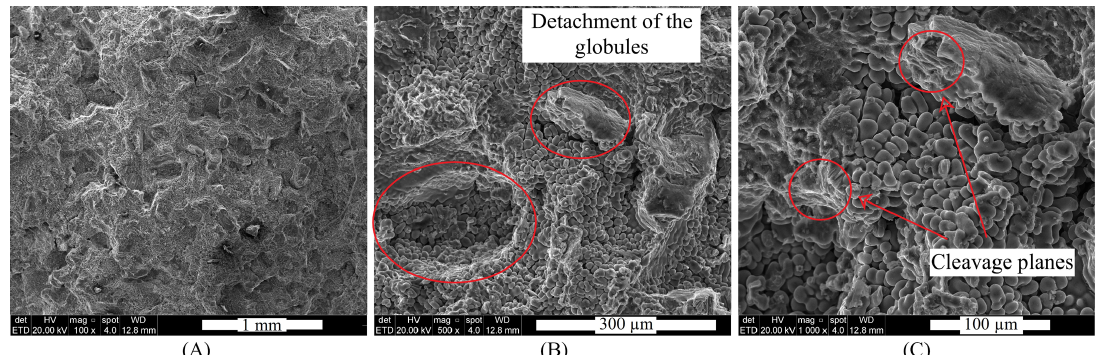
Figure 10. Fracture surface of the 12 mm sample mechanically stirred for 2